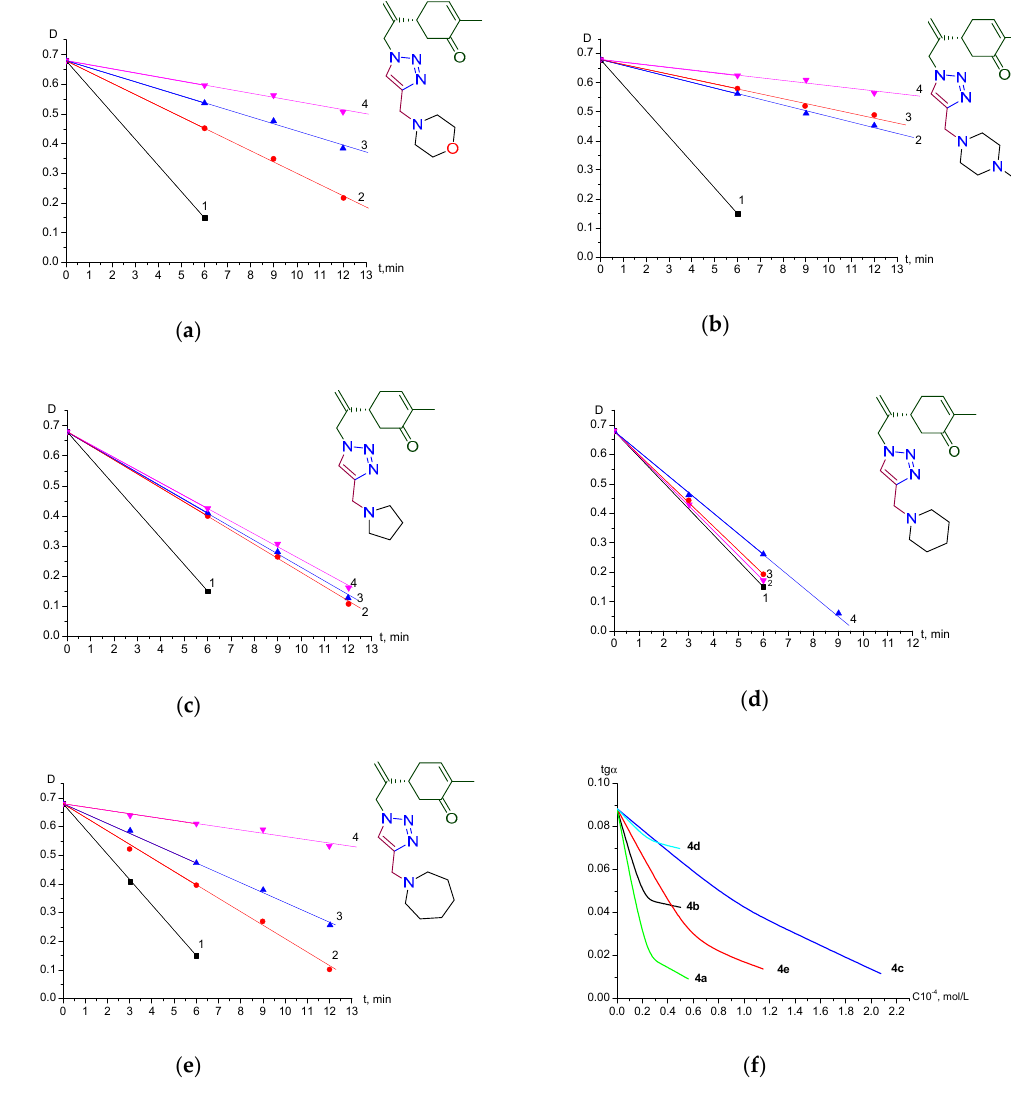
Figure 4. ( a ) compound 4a ; ( b ) compound 4b ; ( c ) compound 4c ; ( d ) compound 4d ; ( e ) compound 4e . Dependence of optical density of PNDMA vs the time of UV irradiation ( λ = 313 nm) at various concentrations of compounds 4a – e ; ( f ) dependence of rate of PNDMA discoloring (in units) vs the concentration: compounds 4 а – e .